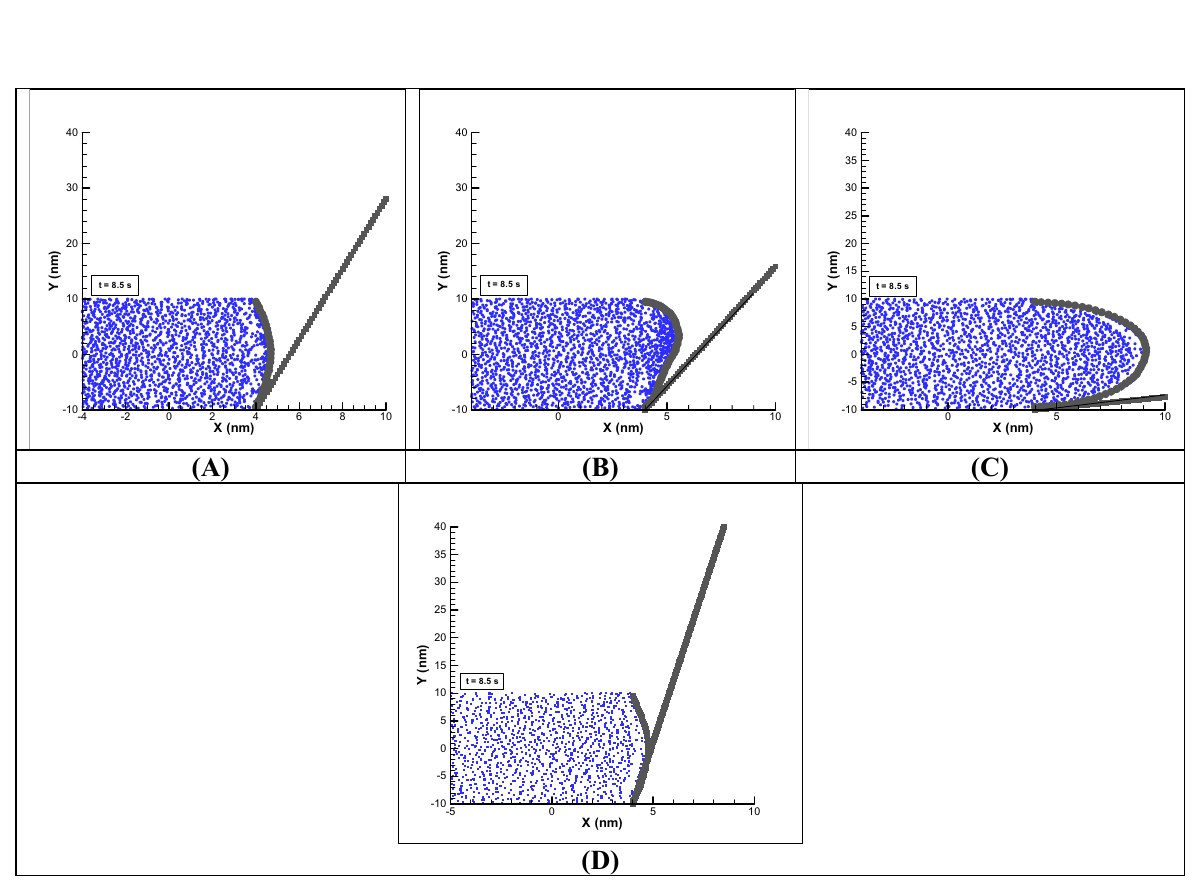
Figure 7. Effect of DPD-polymer parameters on angular rotation of stem compared to Fig. 3 (last frame). Variations of beads number (left to right respectively) from 50 to 30 ( A ), repulsive parameters 4 times ( B ), harmony hardness coefficient 0.5 times ( C ) and particle density 0.5 times ( D